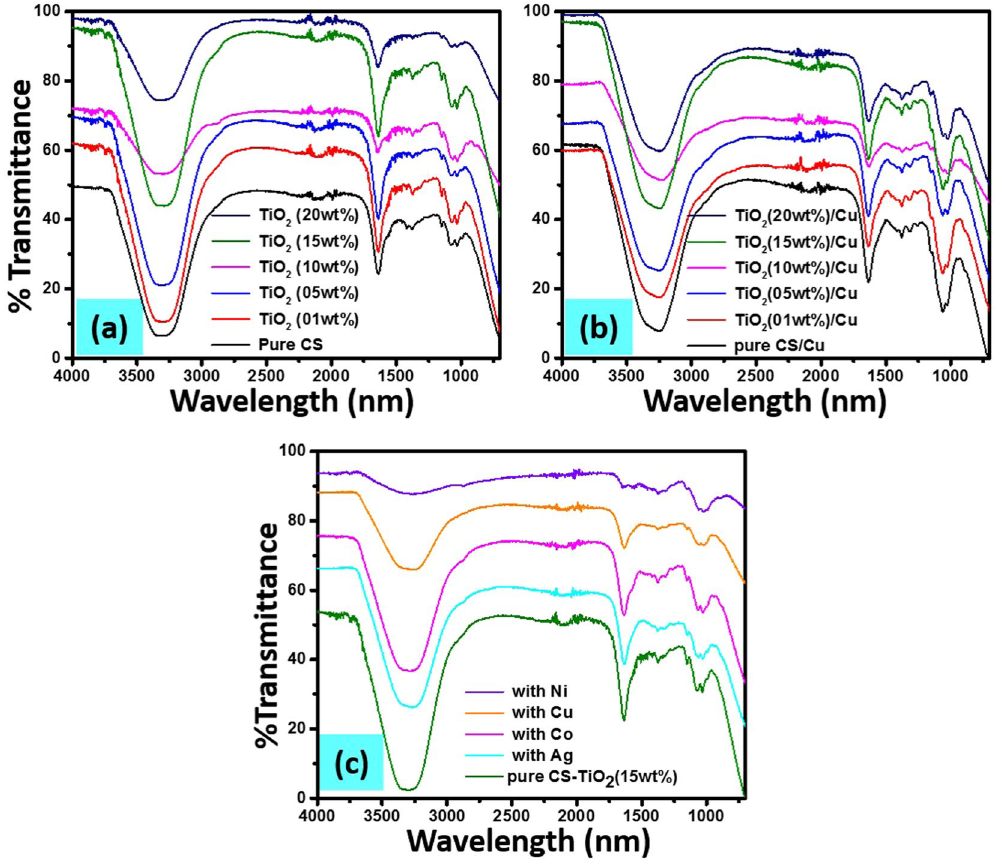
Figure 2. FT-IR spectra of pure chitosan and loaded with different wt% (1, 5, 10, 15, 20 wt%) of TiO 2 ( a ) and their respective zero-valent Cu nanoparticles loaded nanocomposites ( b ), pure CS-TiO 2 (15 wt%) nanocomposite and templated with different MNPs ( c ).